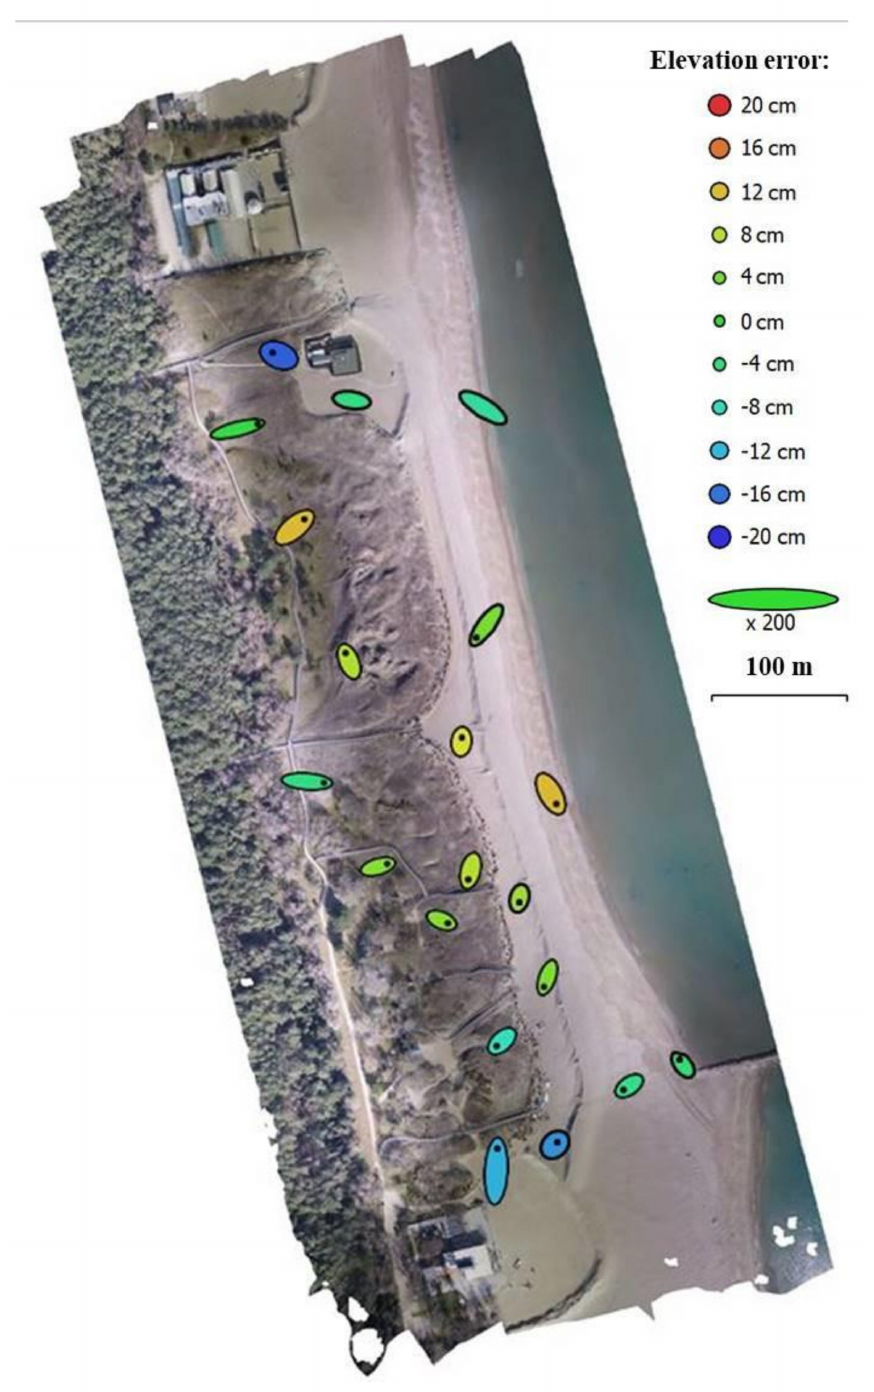
Figure 2. GCP errors, calculated by Agisoft Metashape software. The ellipses’ color represents the elevation error, while planar error is represented by ellipses dimension and shape (February